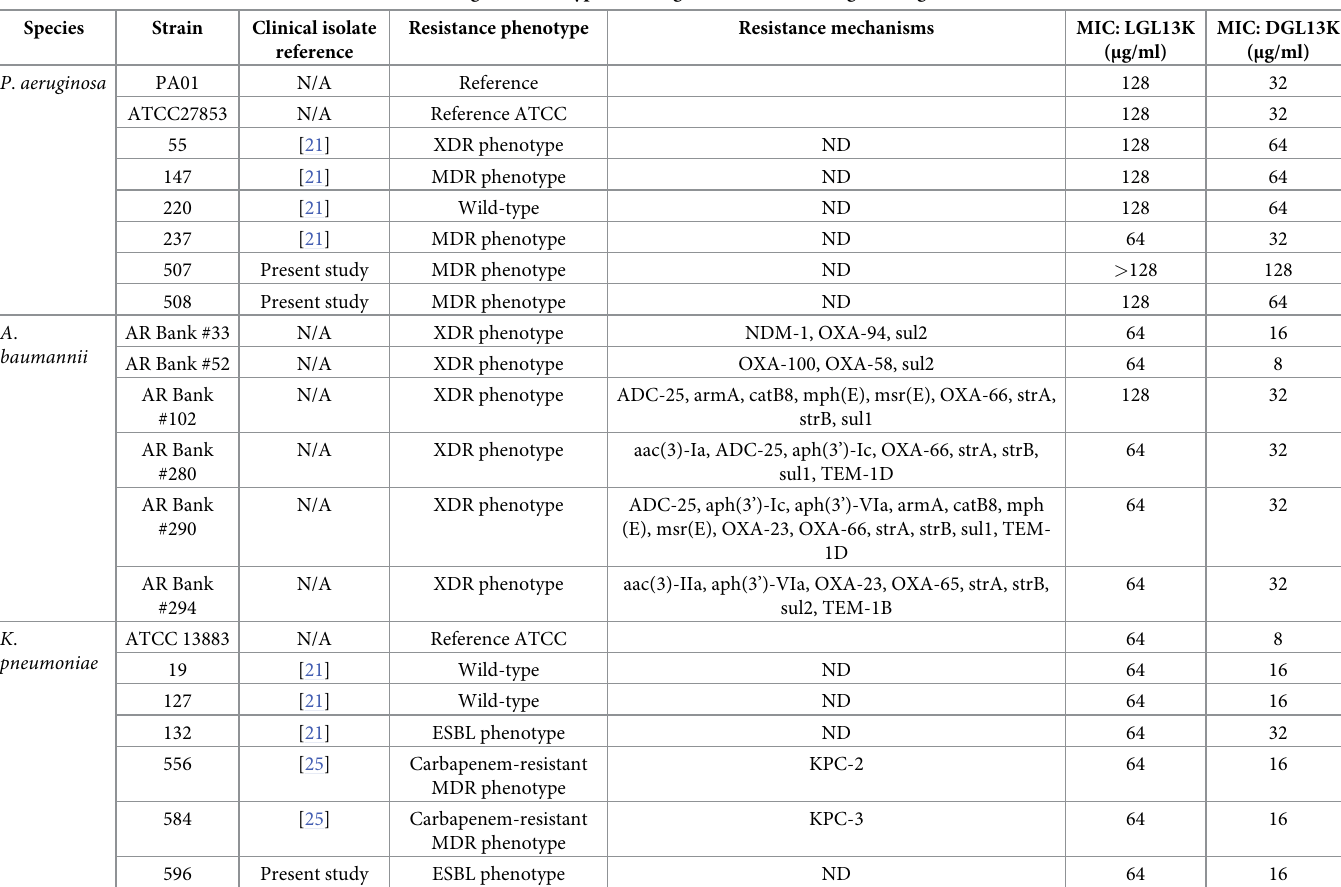
Table 1. LGL13K and DGL13K MIC values determined against wild-type and drug-resistant strains of gram-negative bacteria. Species